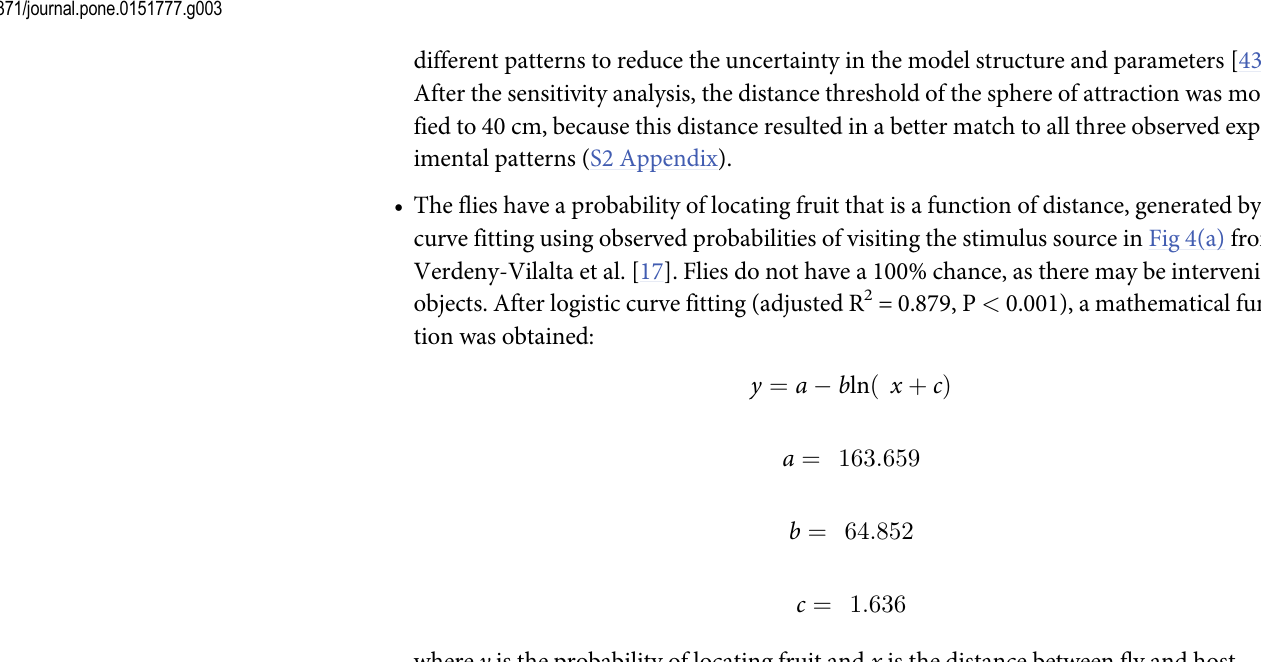
Fig 3. Simulation of individual fly movement through a closed-canopy. Pink cubes show where the fly has already visited with the number of visits, green cubes represent leaves without visits and red cubes represent host fruit without visits. The lines between pink cubs are hop